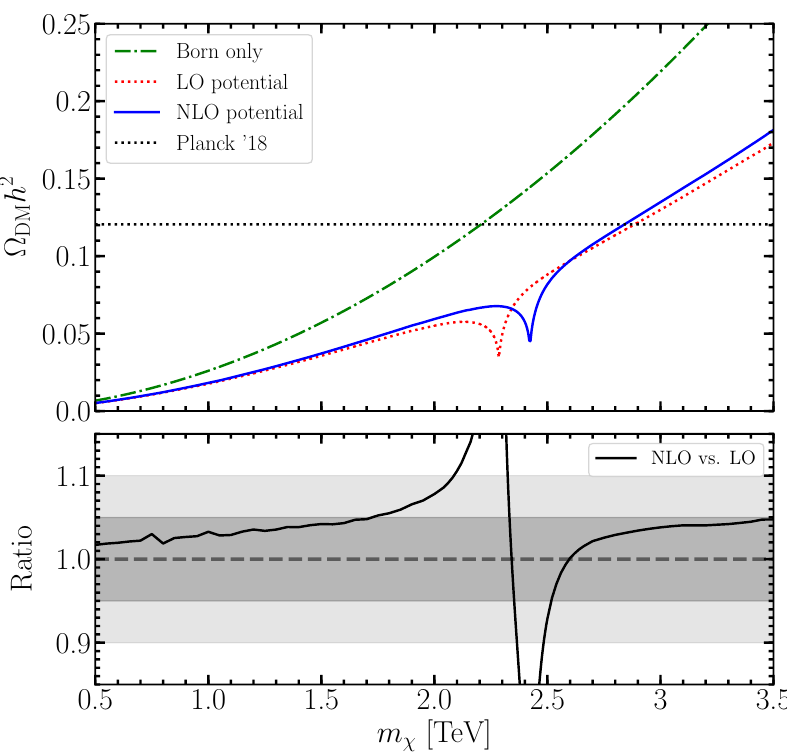
Figure 9 . Wino DM relic abundance as function of DM mass m χ computed with Born cross sections (dashed-dotted/green), including Sommerfeld enhancement with the LO (dotted/red), and the NLO potential (solid/blue). The horizontal line shows the observed relic abundance. In the lower panel, the ratio of the NLO to LO Sommerfeld-corrected relic abundance is shown. The dark (light) grey bands mark the 5 (10)% variations. Except in the vicinity of the resonances the NLO correction is a few percent. The small wiggles in the ratio plot are due to numerical inaccuracies of the